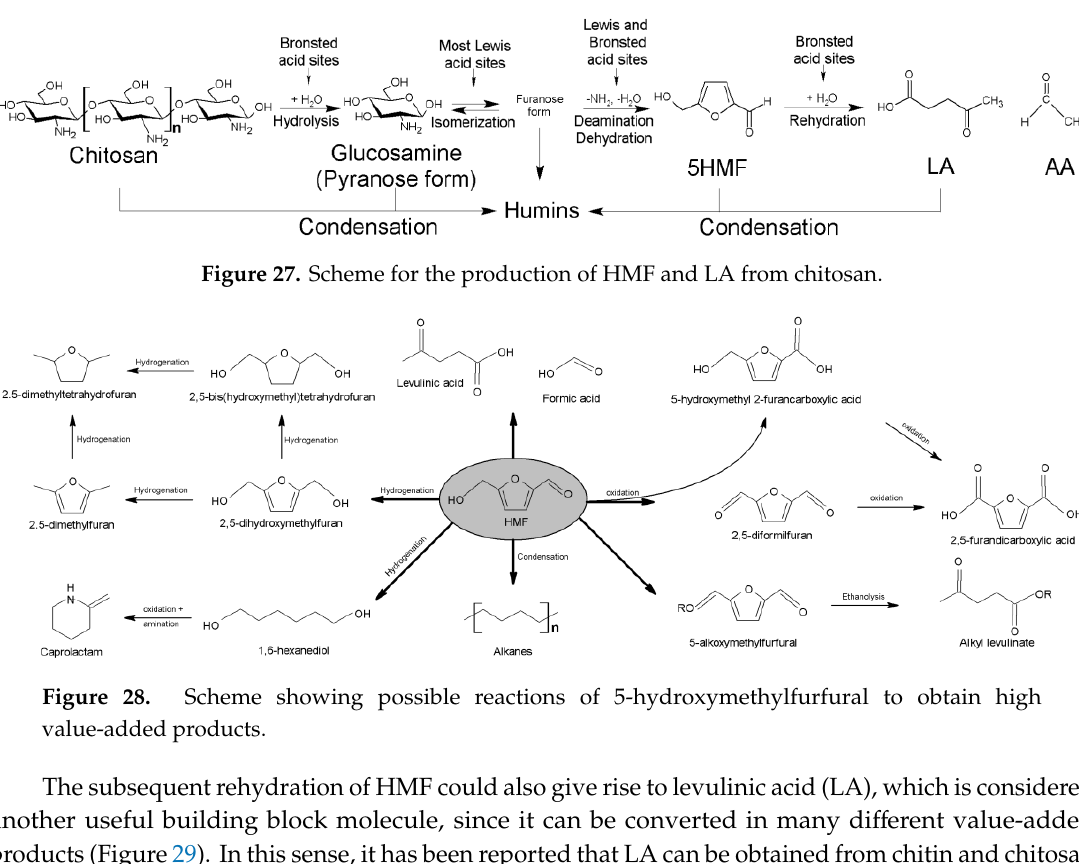
Figure 27. Scheme for the production of HMF and LA from chitosan.